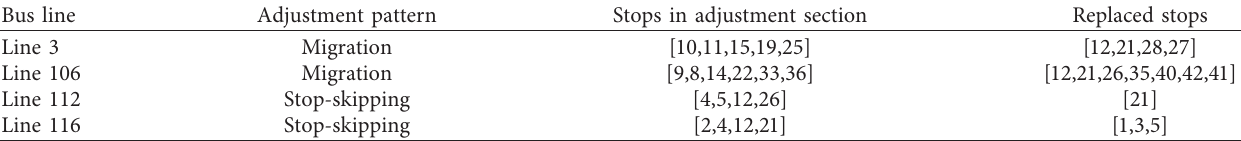
Table 6: Optimal adjustment scheme of bus under the effect of Ning-ma intercity